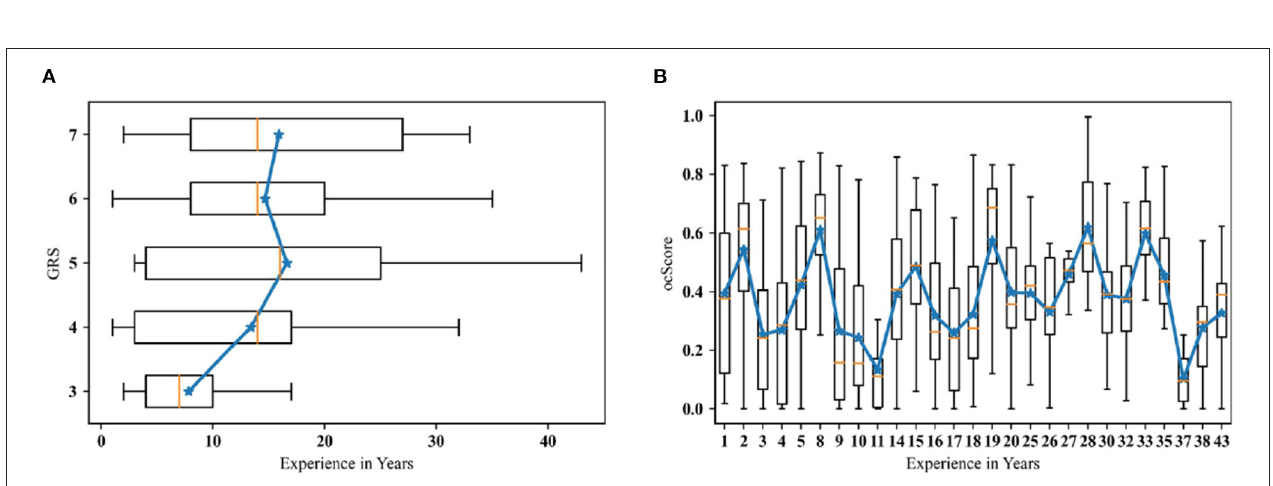
FIGURE 8 | (A) Years of experience grouped by GRS; (B) The outcome score grouped by experience. (Note: Experience is rounded to full years; solid blue lines connect the means of each group).